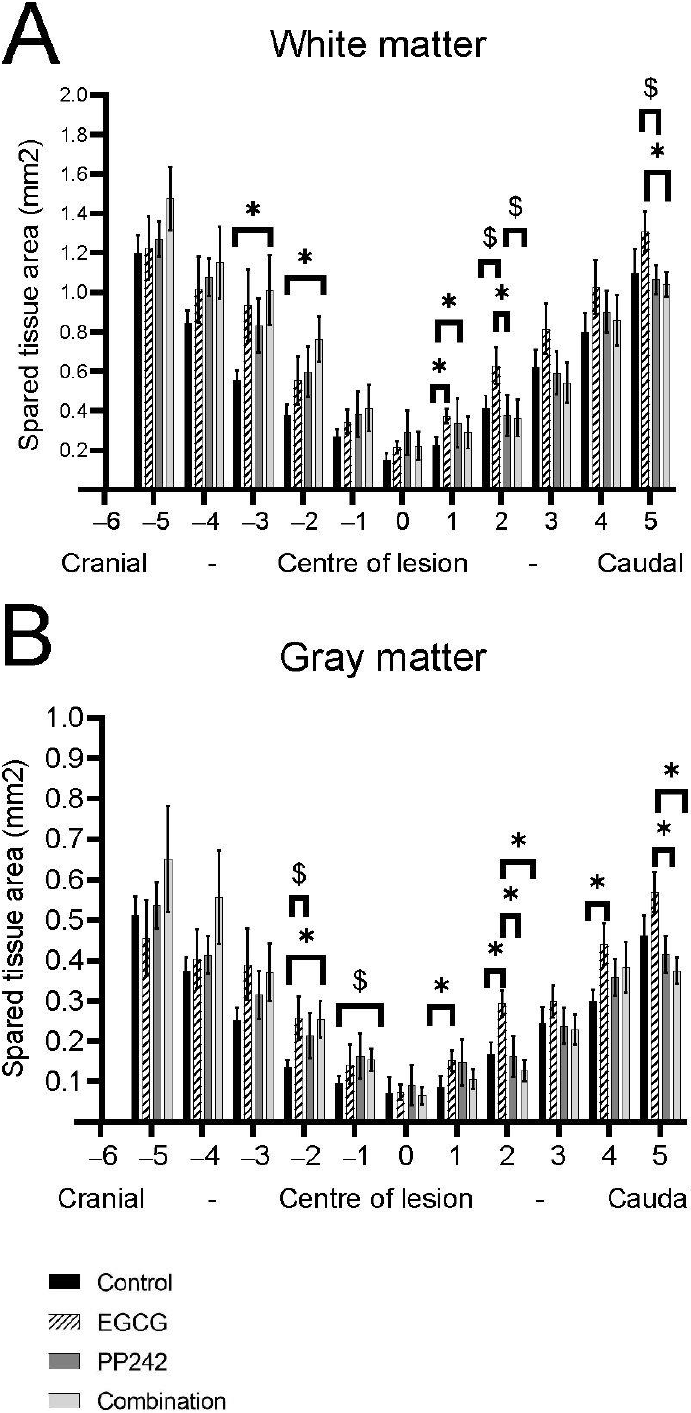
Figure 3. Histopathological and immunohistochemical investigation of the spinal cord lesion. The analysis of the remaining white and gray matter displayed higher preservation of the white and gray matter ( A ) after EGCG treatment compared to other treated groups and controls. The combinatory treatment was also efficient in protecting white and gray matter compared to controls ( B ) (* p < 0.05), ($ p 0.05 – 0.1).